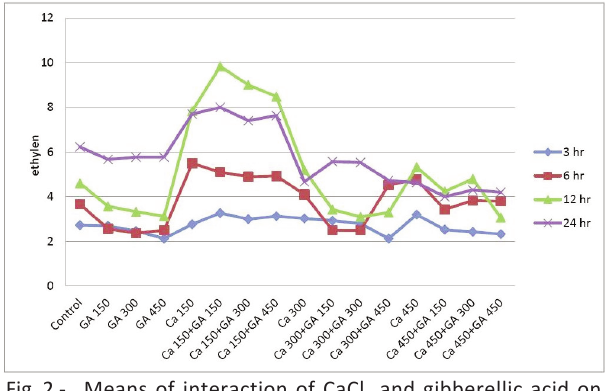
Fig. 2 - Means of interaction of CaCl ethylene production after 1, 2, 3 and 4 hours (nL g -1 h -1 ) of cut